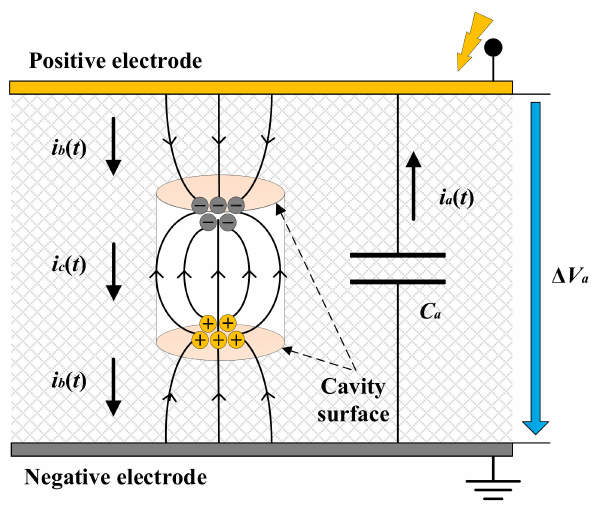
Figure 3. Dipole model to describe PD transient